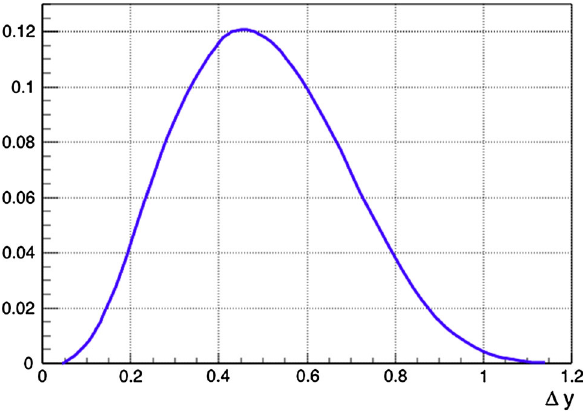
Fig. 4 Rapiditydifferenceofthe (cid:4) cc baryonsproducedbytheintrinsic charm from the target with a 200 GeV/c proton beam σ((cid:4) ) ≈ ( 0 . 2 − 0 . 3 ) × 65nb cc